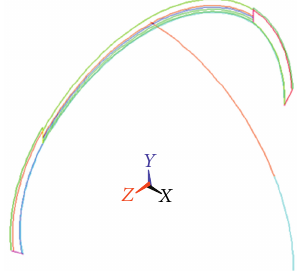
Figure 11: Finite element meshes of 1/2 cranial